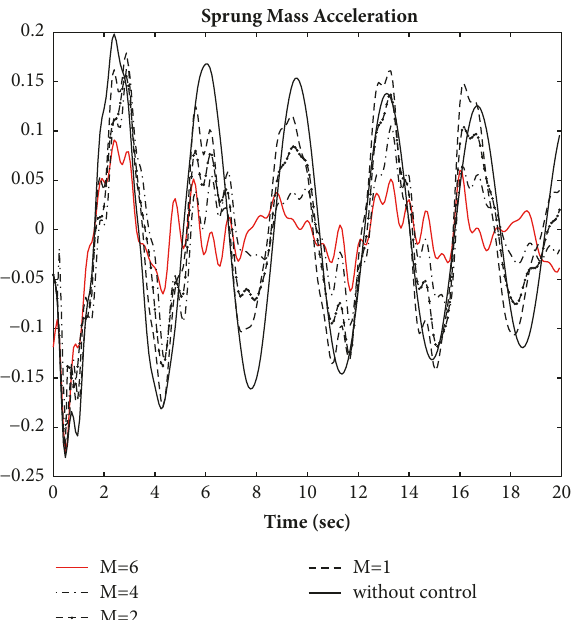
Figure 6: The curve of the tire deflection 𝑧 𝑢 (𝑡) − 𝑧 𝑟 (𝑡) .